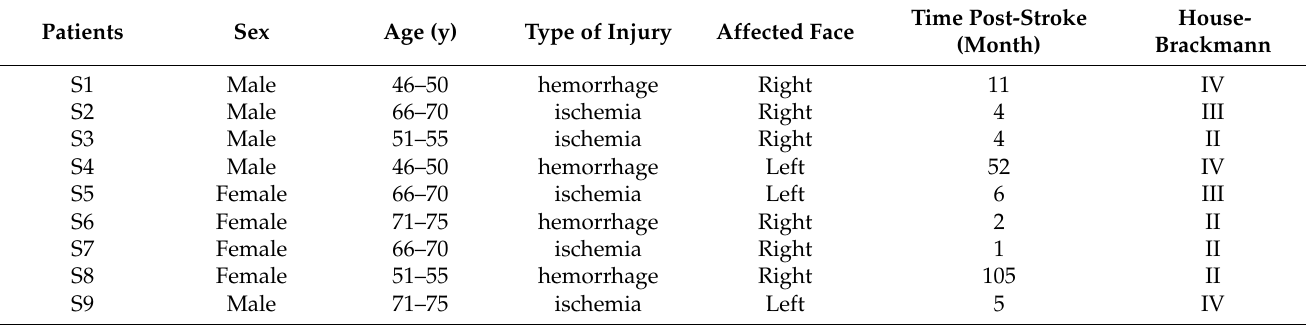
Table 1. The demographic and baseline clinical characteristics of the stroke patients with facial